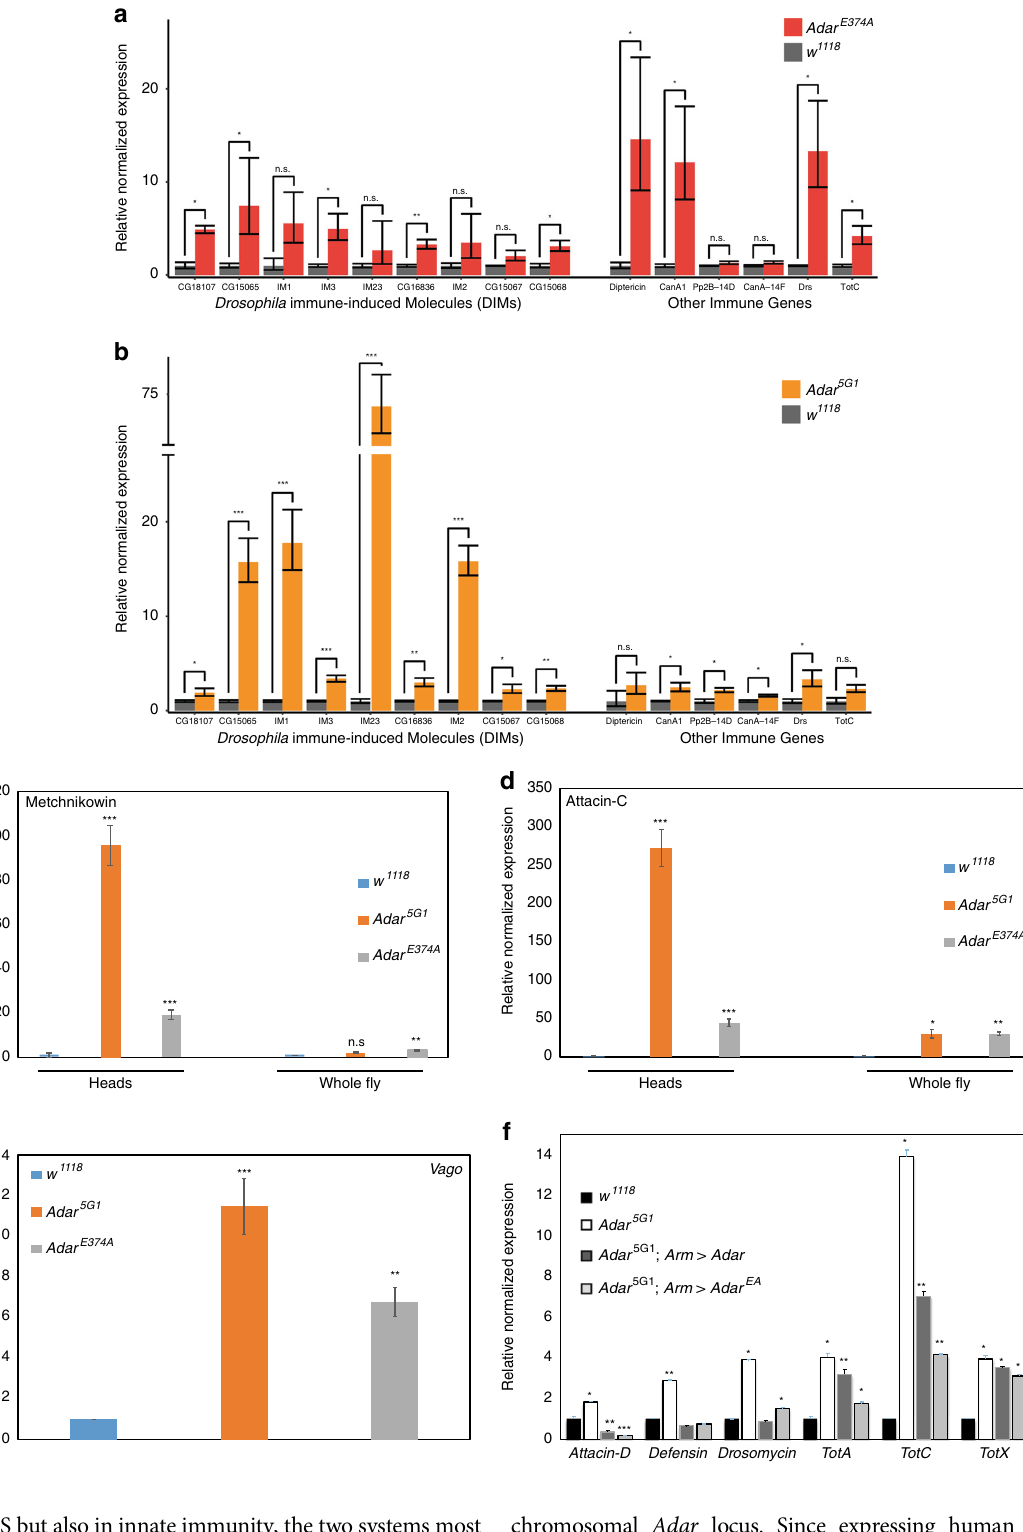
on RNA editing activity when Adar is expressed normally from the